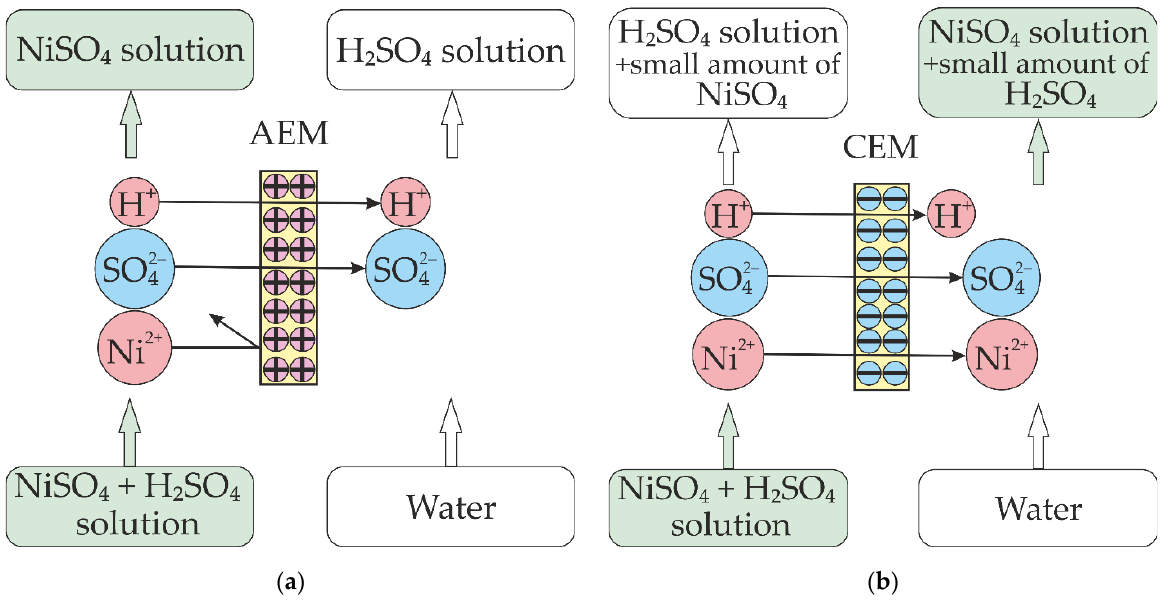
Figure 1. Scheme of ion fluxes though AEM ( a ) and CEM ( b ).